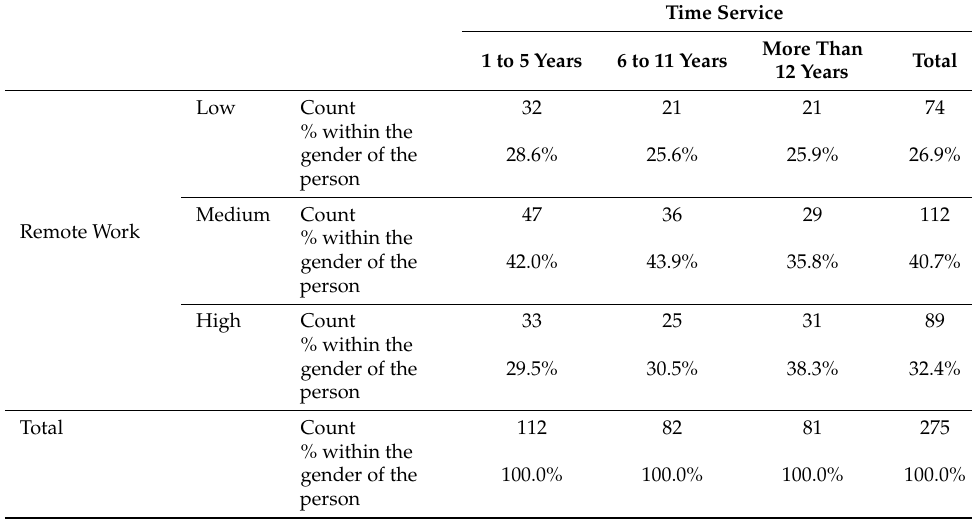
Table 13. Cross table of remote work level and service time.